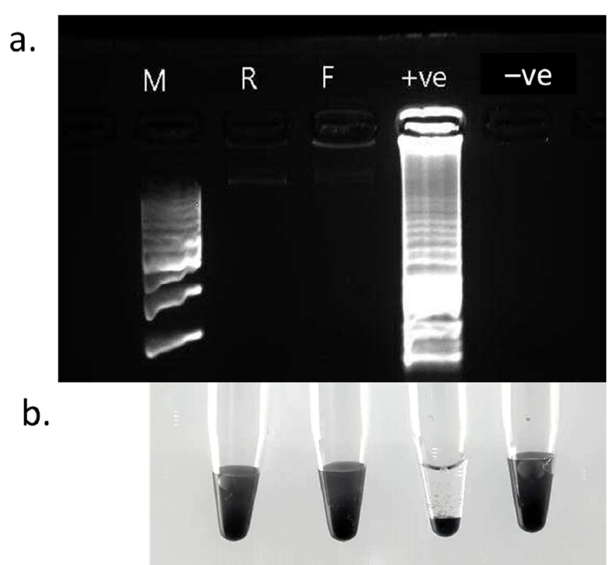
Figure 4. Specificity assessment of the LAMP assay for Ralstonia syzygii subspecies celebesensis genomic DNA by visualisation on agarose gel stained ( a ) and carbon flocculation assay with activated charcoal ( b ). R = Ralstonia solanacaerum; F = Fusarium oxysporum cubense; +ve = positive control ( R . syzygii subspecies celebesensis ); − ve = negative control (without DNA template); M = 100 bp DNA marker. Each figure represents at least 3 experimental replicates.